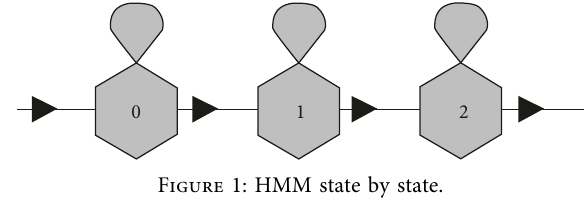
Figure 1: HMM state by state.